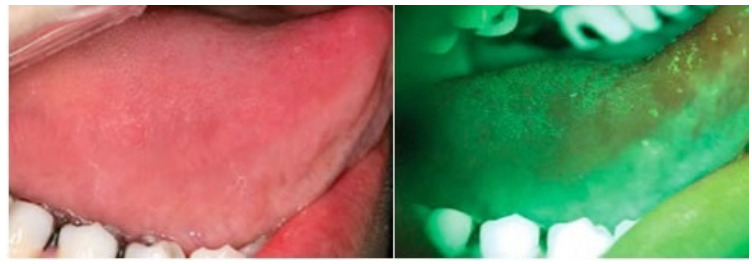
Figure 5. VELscope ® images with Canon A620 settings; the field of view (FOV) is quite straightforward and focused, as in RGB frames.